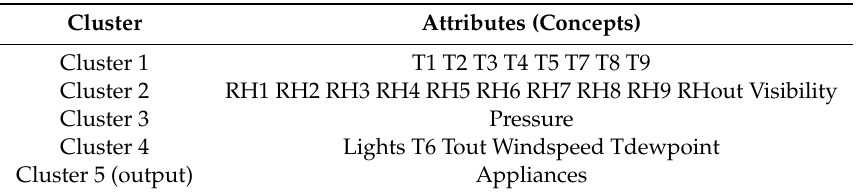
Table 1. Results of clustering.